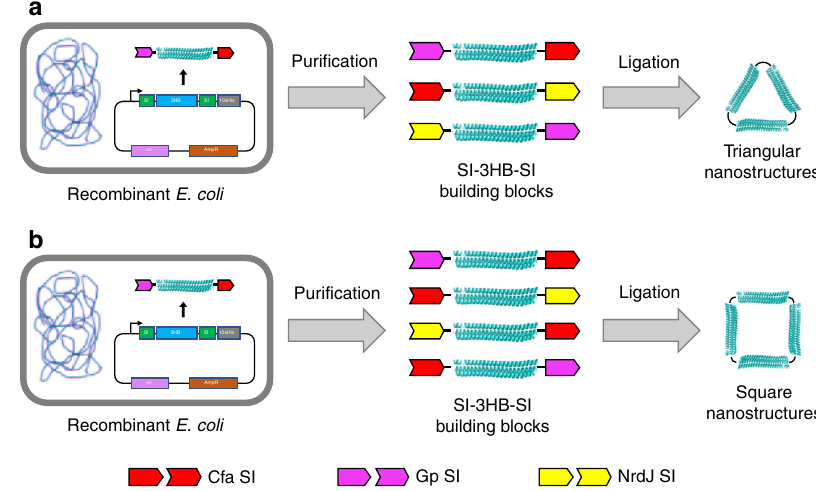
Fig. 1 Schematic illustration of the covalent assembly of triangle and square protein nanostructures. a By genetically fusing cognate SI pairs to the N- and C- termini, three copies of 3HB (PDB:4TQL) can be linked together to form triangular nanostructures. b Using constructs with a different combination of the same orthogonal SI pairs, square nanostructures containing four copies of 3HB can also be made